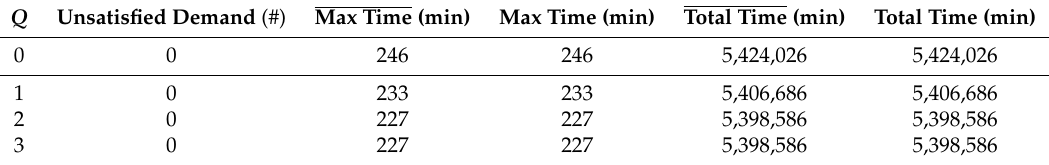
Table 1. Results for the experiment on the deterministic scenario and with fixed